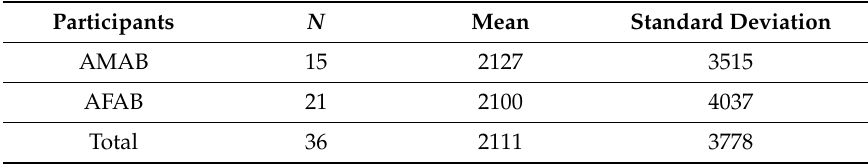
Table 1. Characteristics of